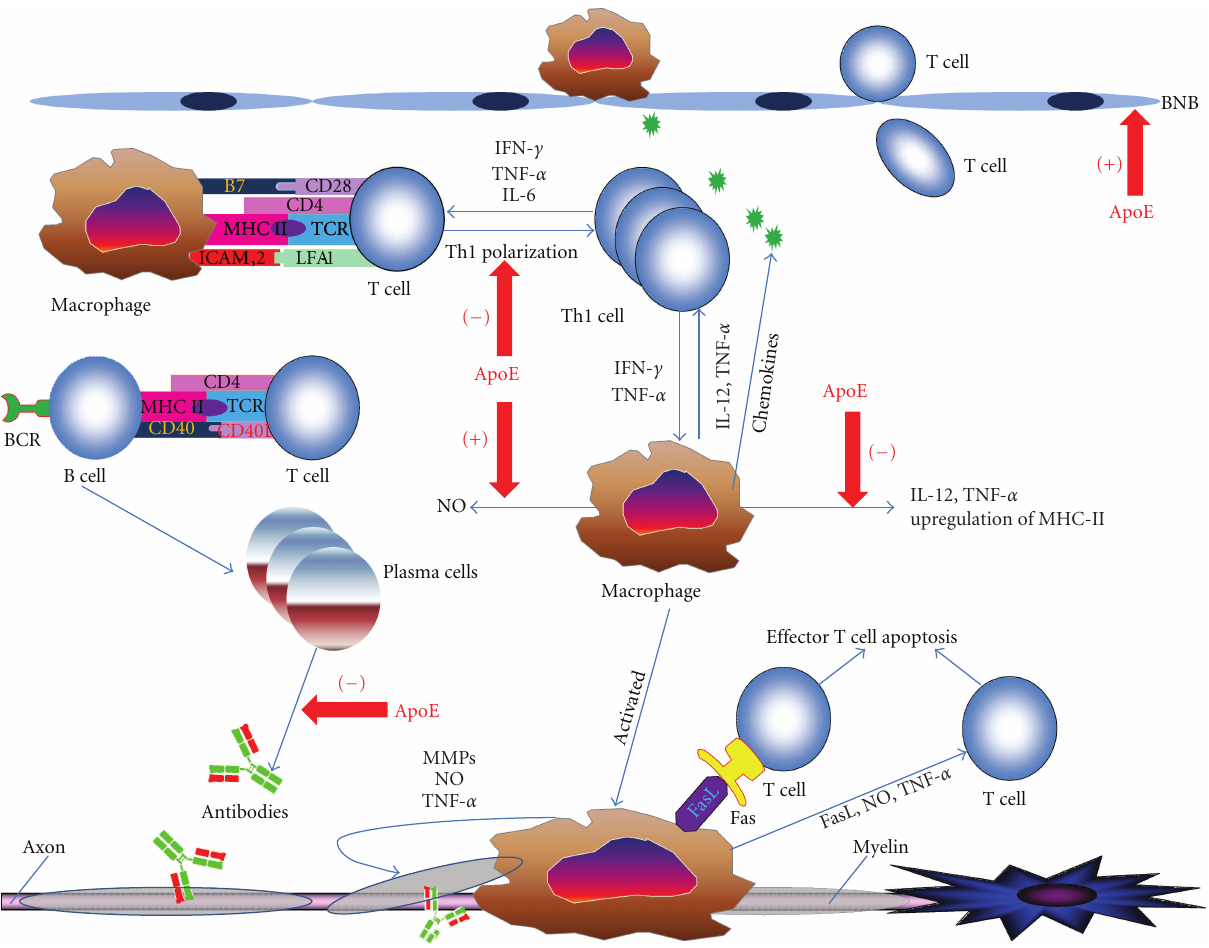
Figure 2: Schematic illustration of the potential role of apoE in the pathogenesis of EAN. ApoE can modulate immune responses in EAN through modification of functions of macrophages, T cells, and BNB, and through shifting Th1/Th2 balance. ( − ) suppressive function; (+) supportive